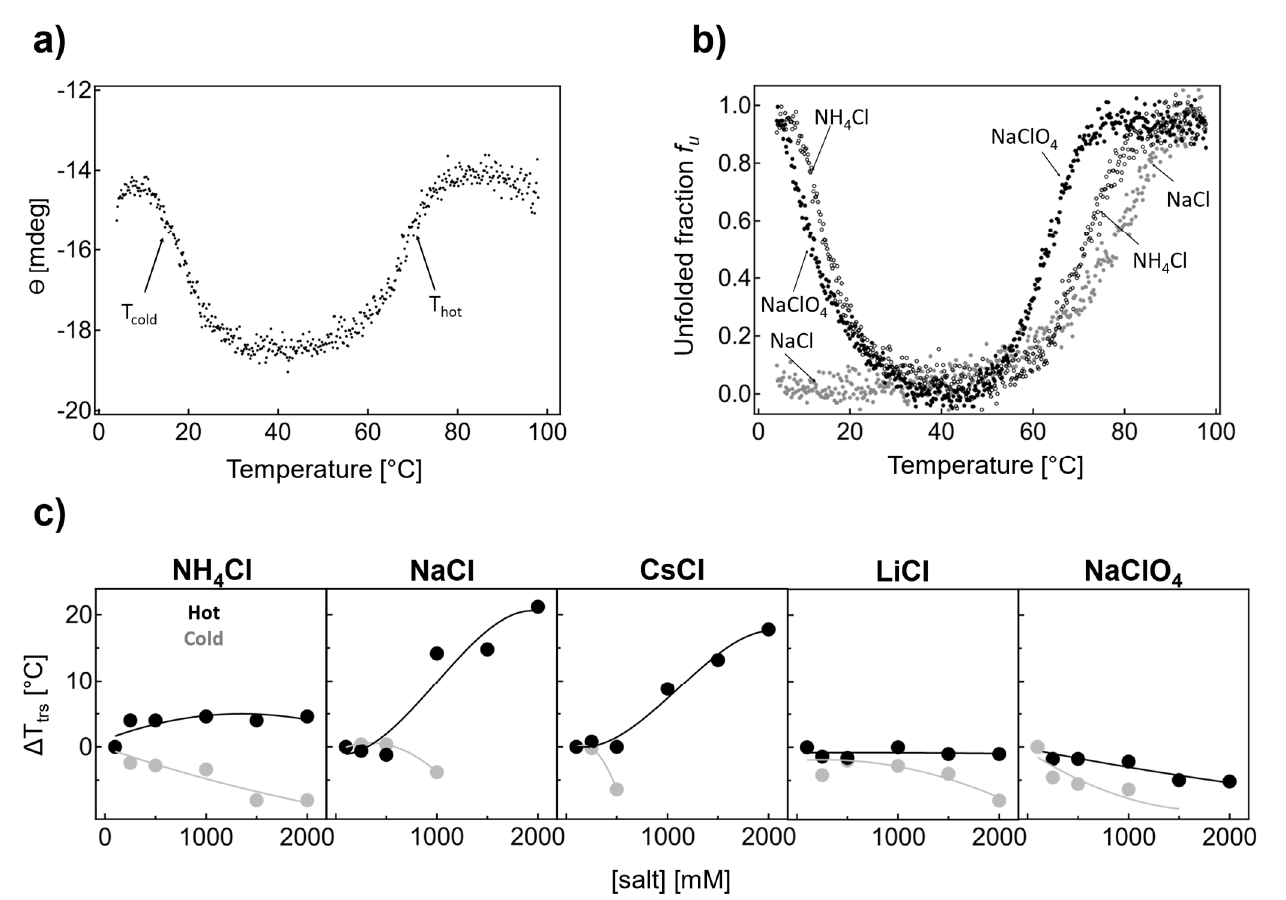
Figure 2. ( a ) Thermal unfolding of IF2 in the presence of 0.1 M NaCl, 9 M urea in the buffer monitored by circular dichroism in the far − UV region at 222 nm. ( b ) Thermal denaturation of IF2 in the presence of 1.5 M NaCl, NH 4 Cl, and NaClO 4 plotted as an unfolded fraction (f u ) vs. temperature (T). For the corresponding CD spectra of IF2 shown in ( a ) at 4, 40, and 95 ◦ C, see Figure S1, Supplementary Materials. Data were normalized based on the averaged signal measured when the protein is folded (between 35 and 45 ◦ C) and to the U state based on the average signal measured when the protein is unfolded (>90 ◦ C, for fitting see Figure S2, Supplementary Materials). ( c ) The thermal denaturation of IF2 in 0.1–2 M NH 4 Cl, NaCl, CsCl, LiCl, and NaClO 4 ( T trs, cold are labeled in gray and T trs, hot in black).